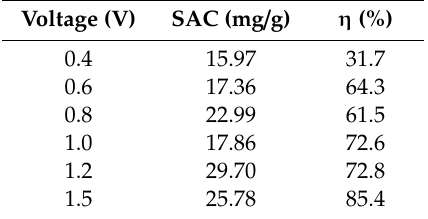
Table 4. The SAC and removal rate of CA electrodes for CuSO 4 solution at di ff erent